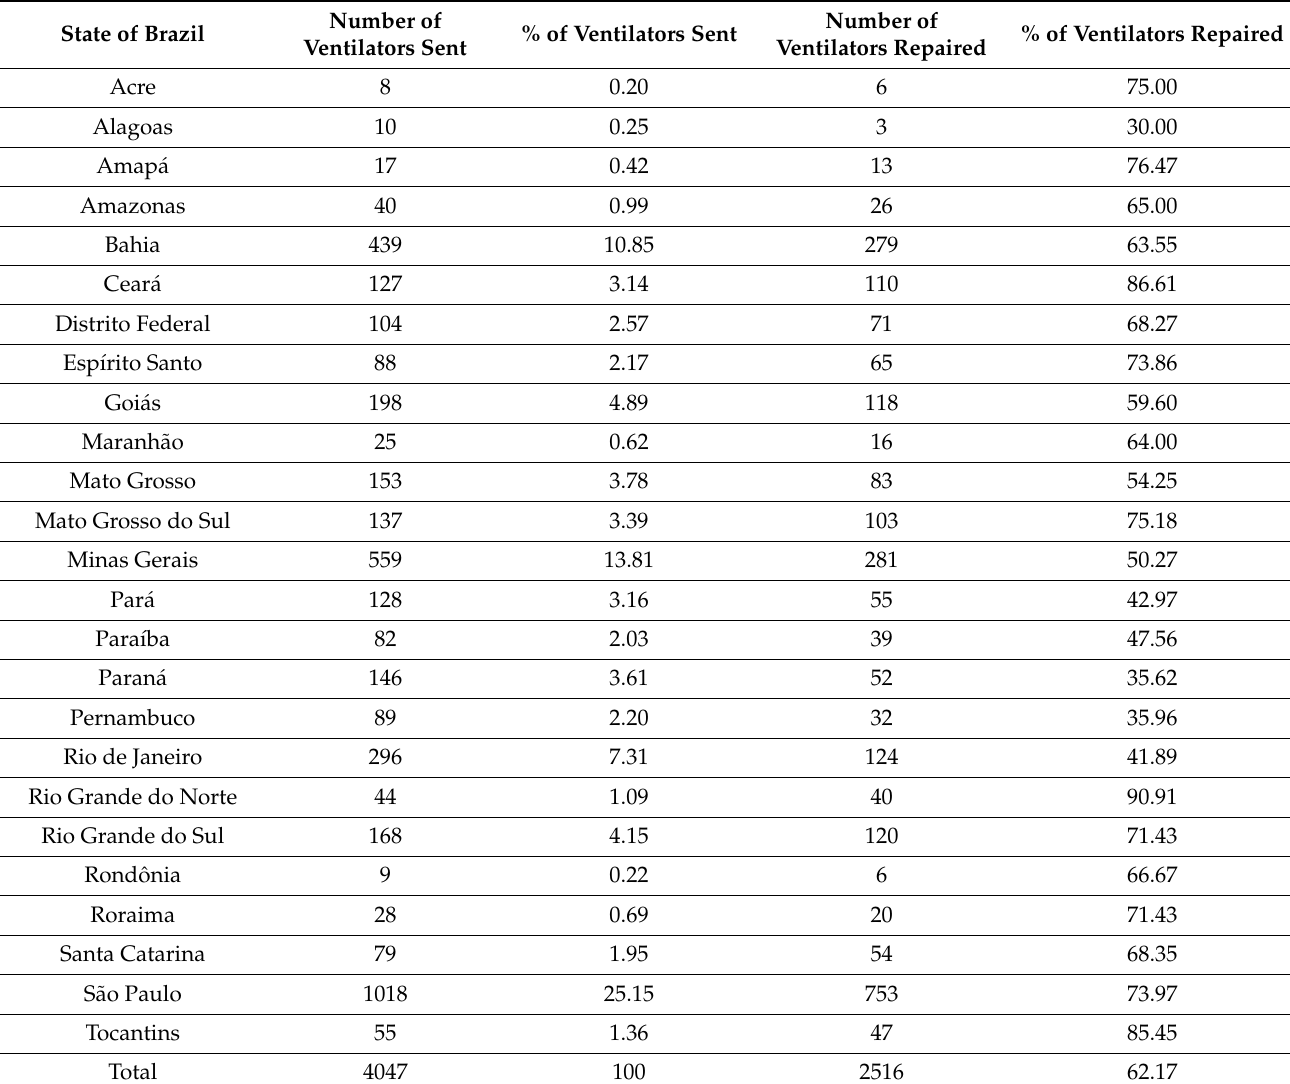
Table 3. Distribution per state in Brazil of ventilators received and repaired (success